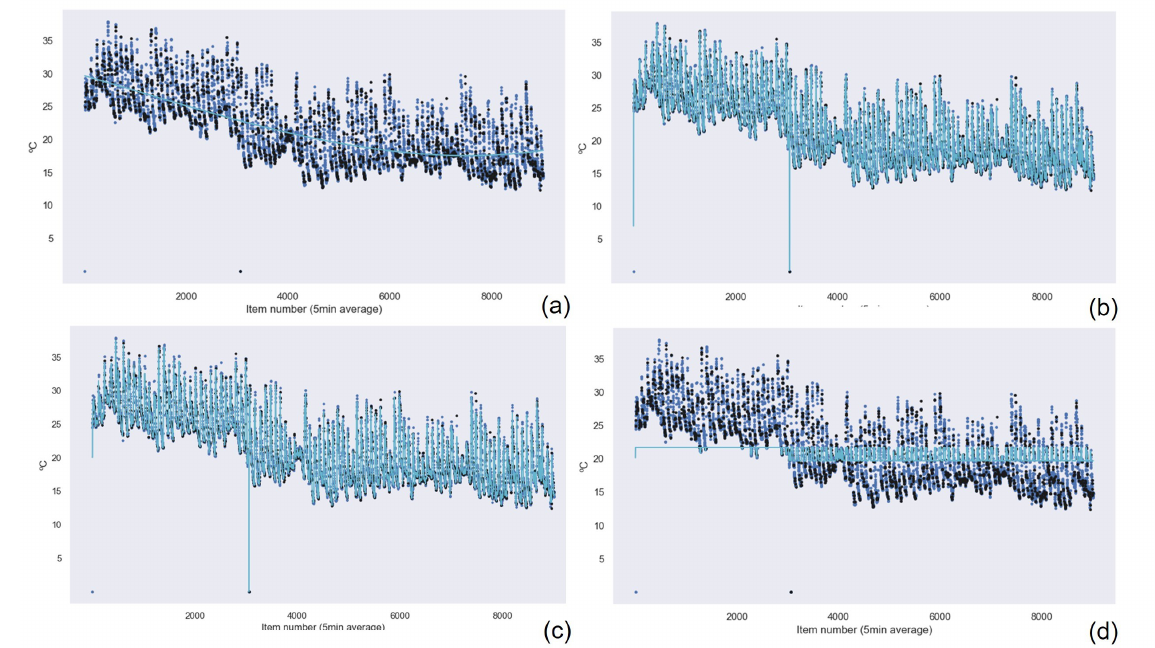
Figure A18. Cont